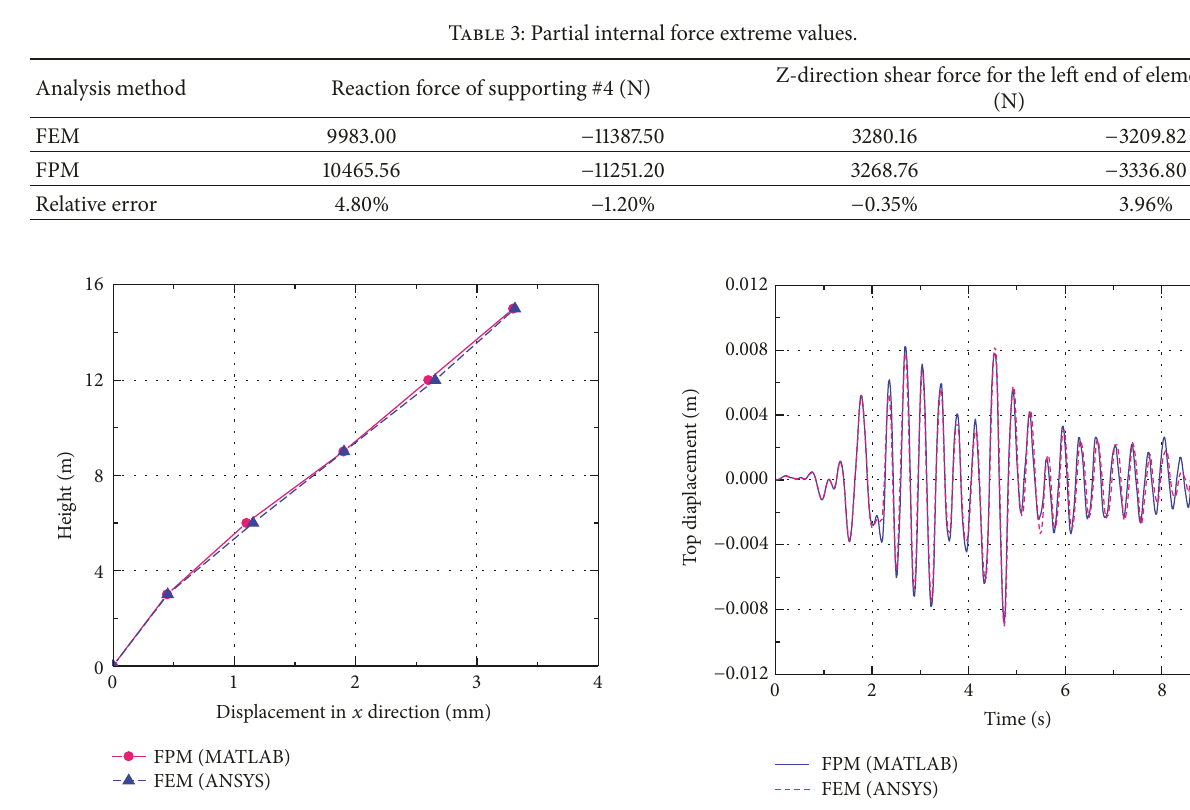
Figure 26: X-direction displacement of various heights under horizontal point loading.